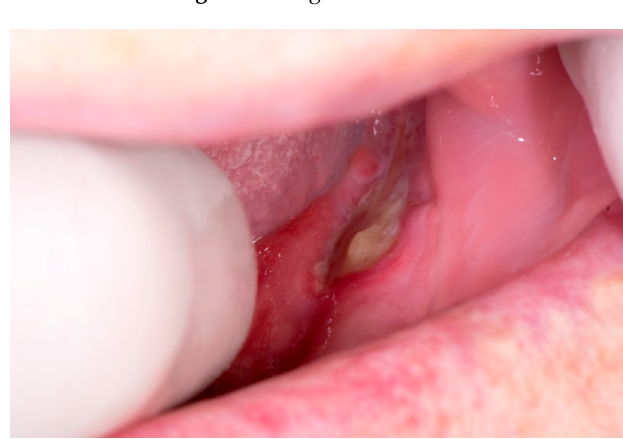
Figure 1. Tongue ulceration.